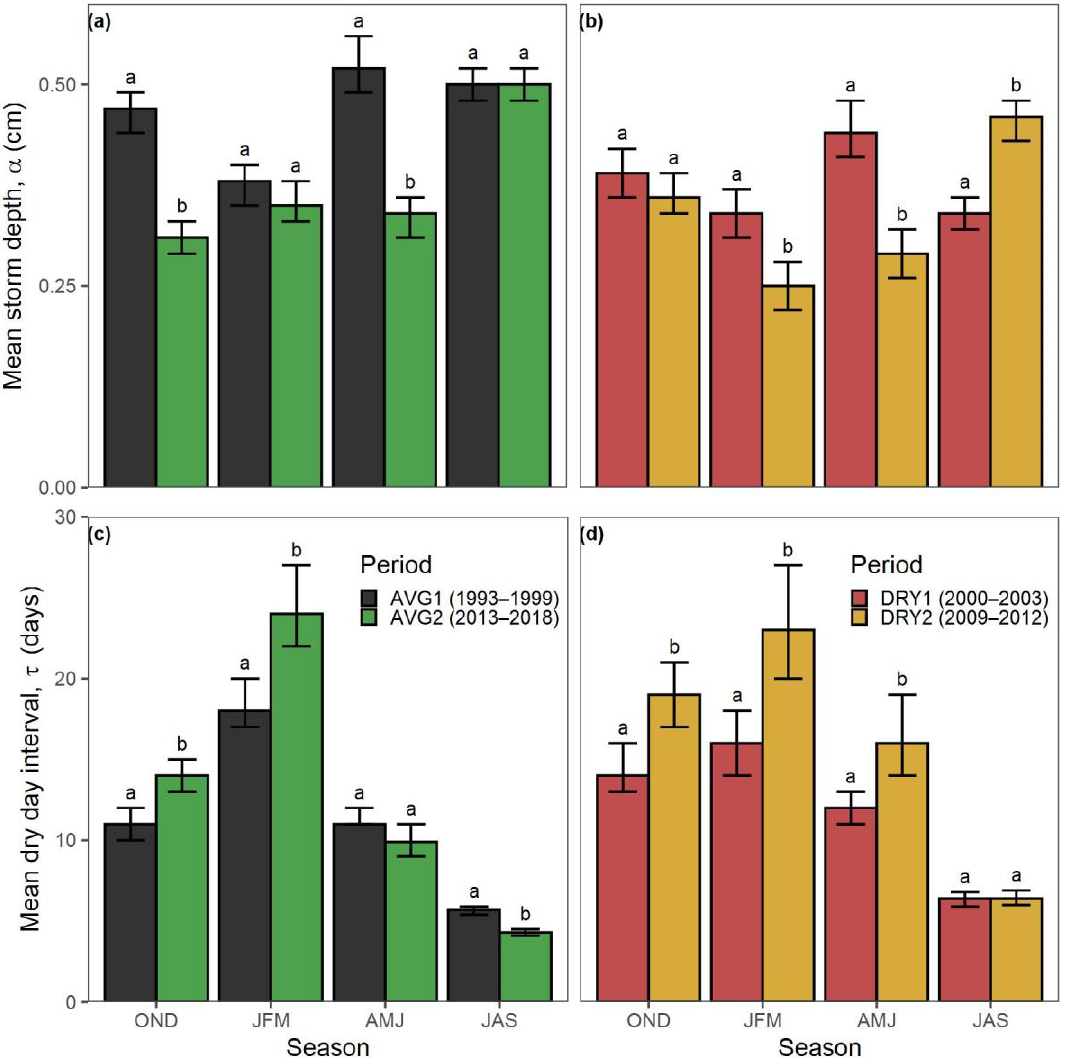
Figure 7. Mean storm depth ( a , b ) and dry-day interval ( c , d ) by season for AVG1 vs. AVG2 (left) and DRY1 vs. DRY2 (right). Bar height denotes median bootstrapped parameter estimates, and error bars denote 95% confidence intervals for the estimates.